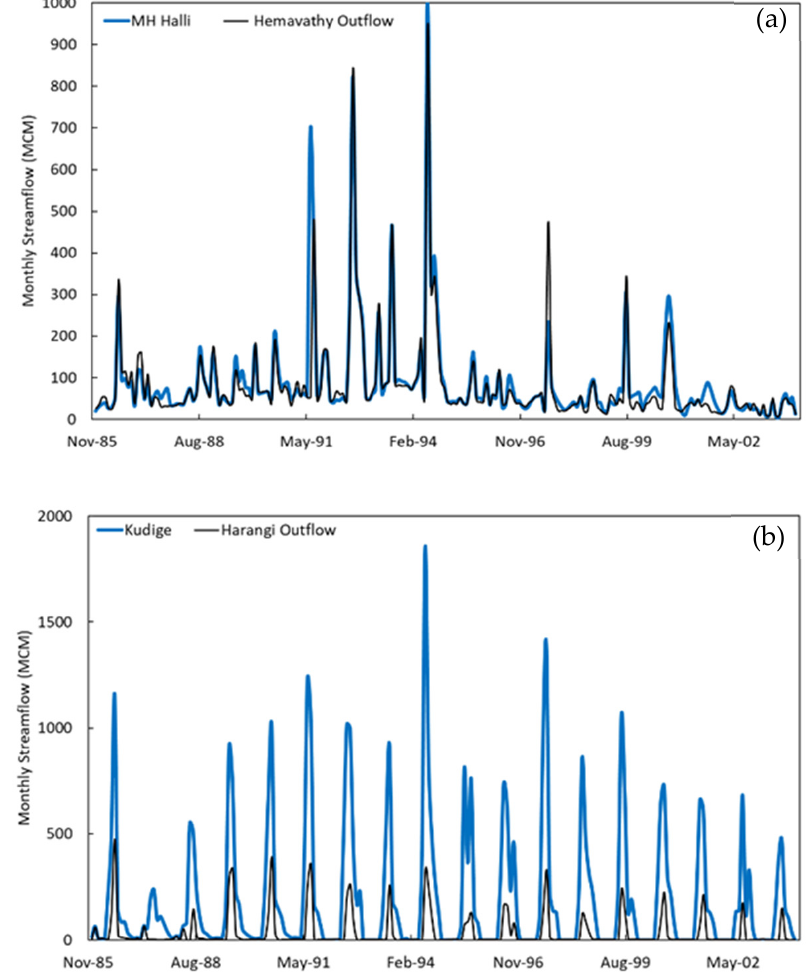
Figure 2. The monthly observed streamflow from ( a ) M H Halli gauging station and Hemavathy reservoir outflow and ( b ) Kudige gauging station and Harangi reservoir outflow.